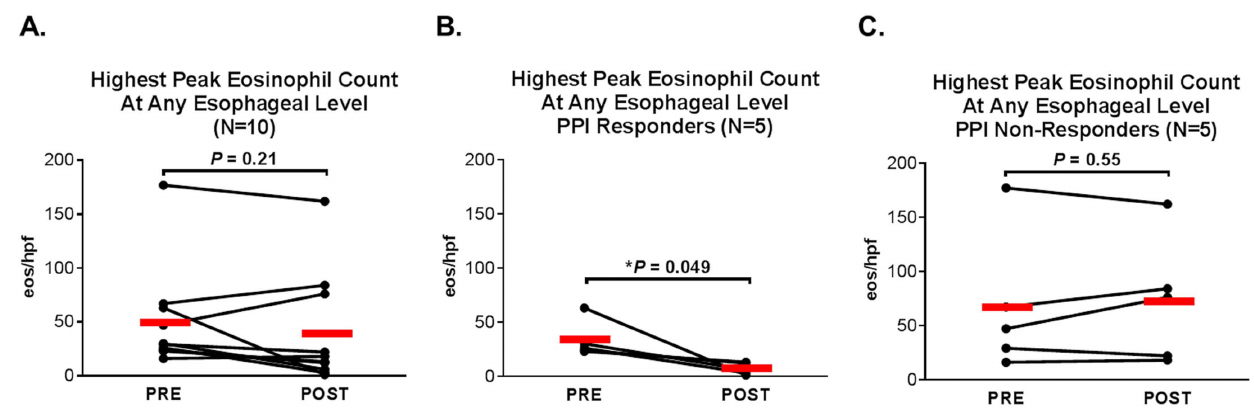
Figure 2. Highest peak eosinophil count at any esophageal level. Highest pre- and post-PPI treatment peak eosinophil counts in (A) all PPI- treated cases, (B) PPI responders, and (C) PPI non-responders. Red bars represent means.